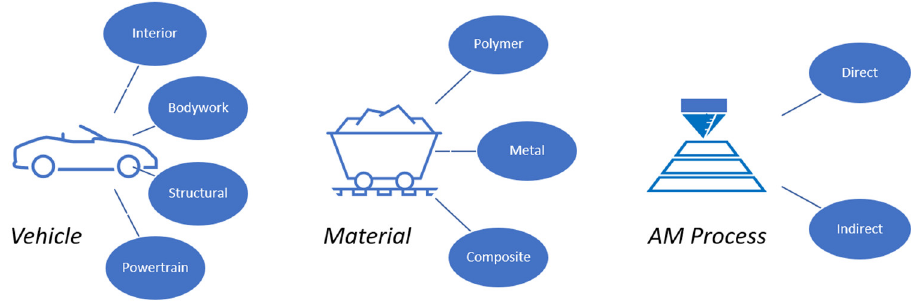
Figure 2. Automotive application classification according to: vehicle areas–materials–AM